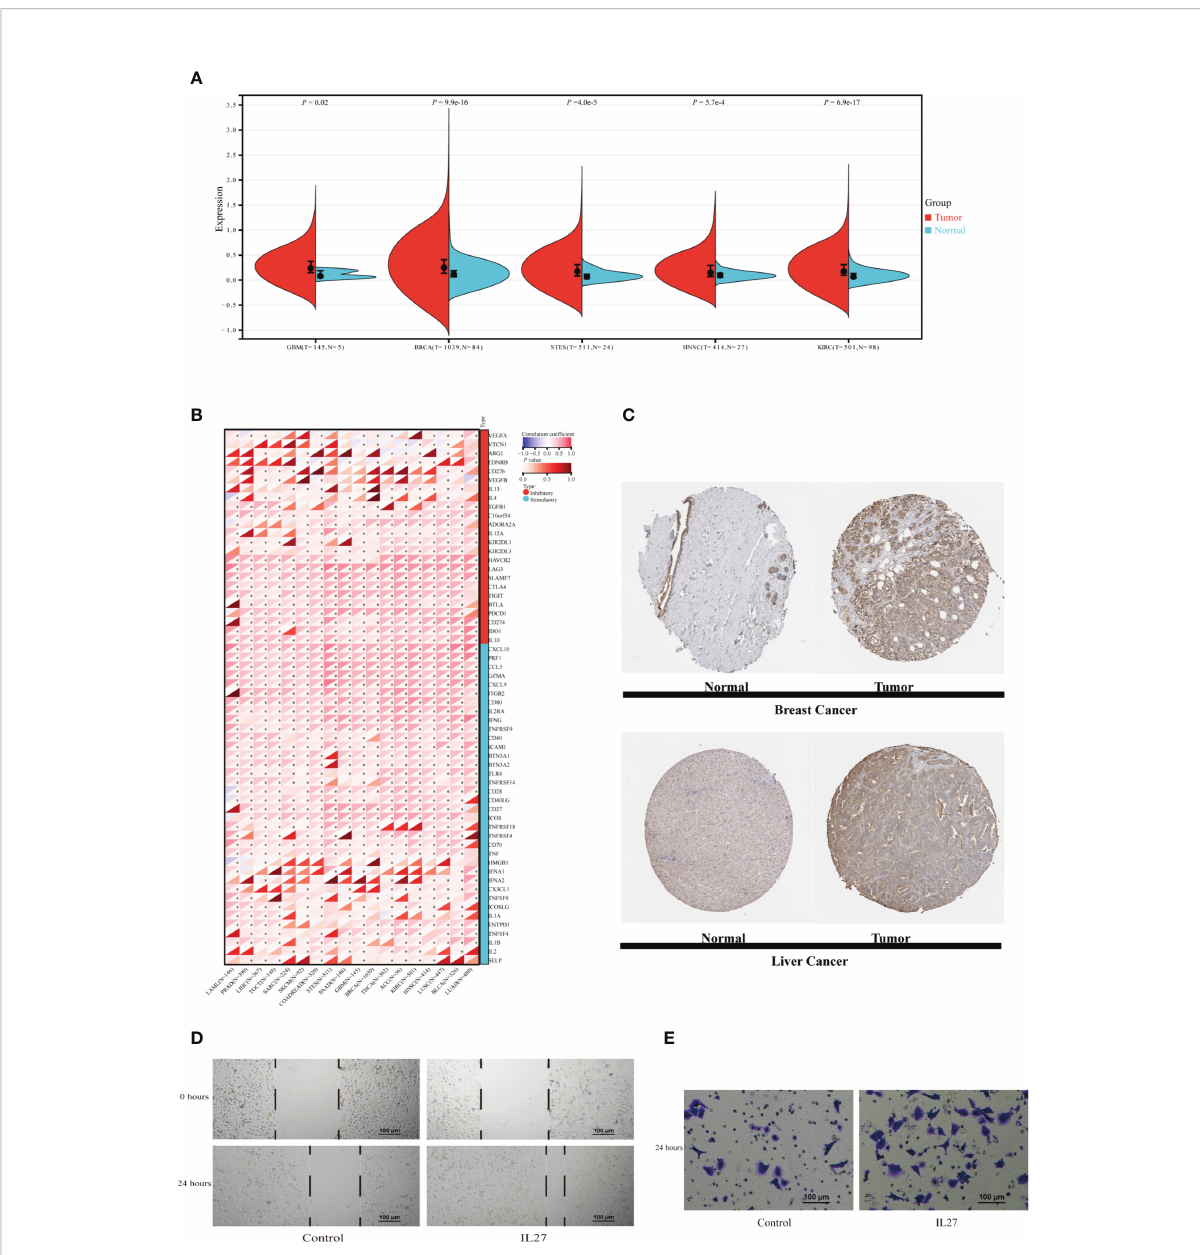
FIGURE 8 Exploration of IL27 expression characteristics and its association with the immune landscape in pan-cancer. (A) The expression of IL27 was compared between tumor tissue and normal tissue in different types of cancer in the TCGA database. (B) The correlation between expression of IL27 and immune regulatory gene expression analyzed using Pearson correlation test among 18 types of cancer. * p <0.05. (C) Protein expression of IL27 in normal and tumor tissues obtained from Human Protein Atlas. MDA-MB-231 cells were incubated with or without IL27 (50 ng/ml) for 24 h. Scratch test (D) and transwell migration assay (E) of MDA-MB-231. GBM, glioblastoma multiforme; BRCA, breast invasive carcinoma; STES, stomach and esophageal carcinoma; HNSC, head and neck squamous cell carcinoma; KIRC, kidney renal clear cell carcinoma; LAML, acute myeloid leukemia; PRAD, prostate adenocarcinoma; LIHC, Liver hepatocellular carcinoma; TGCT, testicular germ cell tumors; SARC, sarcoma; SKCM, skin cutaneous melanoma; COADREAD, colon adenocarcinoma or rectum adenocarcinoma; EC, esophageal carcinoma; PAAD, pancreatic adenocarcinoma; THCA, thyroid carcinoma; ACC, adrenocortical carcinoma; LUSC, lung squamous cell carcinoma; BLCA, bladder urothelial carcinoma; LUAD, lung adenocarcinoma; T, tumor tissue; N, normal